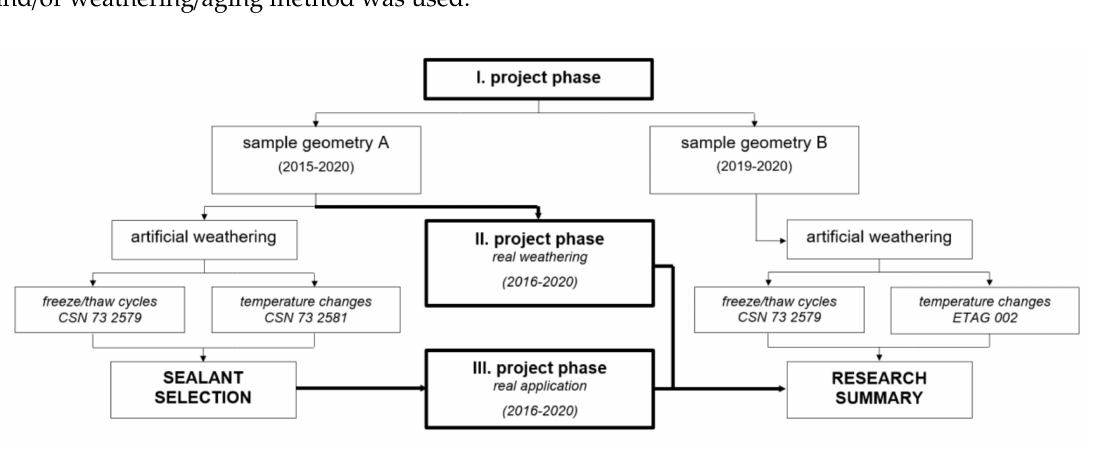
Figure 2. Simplified graphic illustration of the research